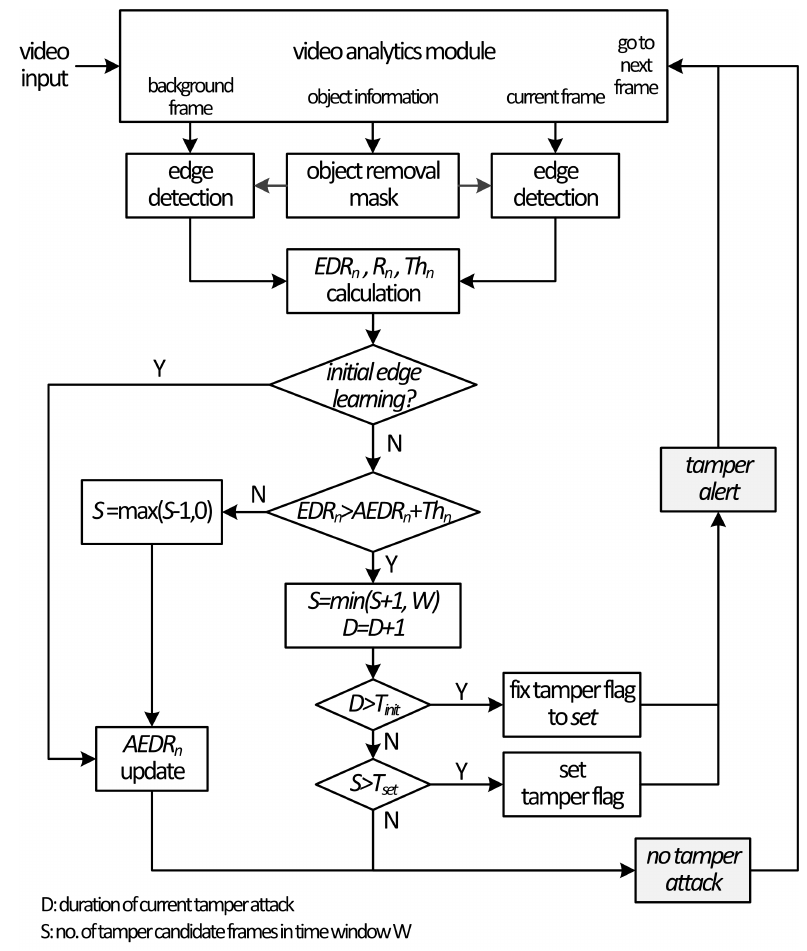
Figure 3. Proposed camera tamper detection algorithm with an adaptive threshold for a unified detection